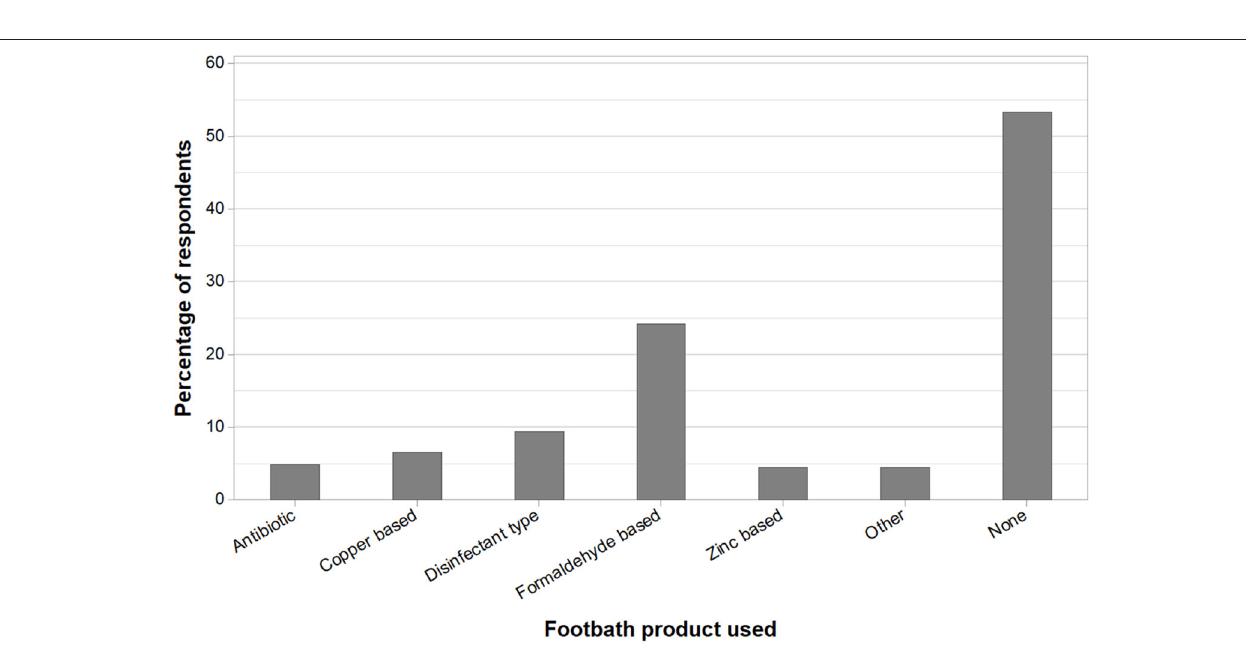
FIGURE 7 | Farmer self-reported foot bath products, as a percentage of respondents. Farmers could state multiple products. “Other” included: a water footbath, products that could not be remembered, or farmer stating that the product used would be based on advice at the time of foot bathing. There were 53% (130) farmers that reported they do not use a footbath product (Q9, n =